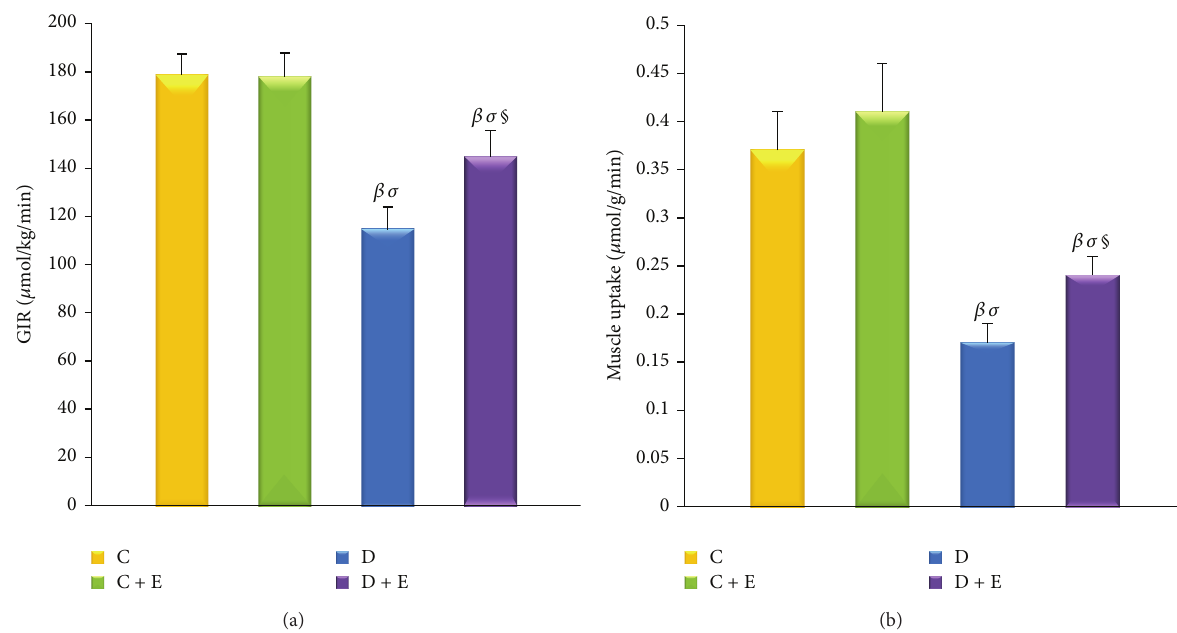
Figure 6: Exogenous glucose infusion rates (GIR) and 2-deoxyglucose uptake into muscle. The GIR required to maintain the glucose levels at the clamp point (6-7mmol/L) was higher ( 𝑃 < 0.01 ) in the D + E group rats than that in the D group rats, while it was still significantly lower ( 𝑃 < 0.01 ) than that in the C group rats. The GIR did not differ between the C group rats and in the C + E group rats (a). Exenatide treatment for 8 weeks markedly increased glucose uptake in diabetic rat gastrocnemius compared with the vehicle-treated diabetic rats ( 𝑃 < 0.01 ). Increased glucose uptake was also found in the C + E group rats compared with the C group rats, but this did not reach statistical significance (b). C: nondiabetic control; C + E: nondiabetic + exenatide; D: diabetic; D + E: diabetic + exenatide. Data are presented as mean ± SD. ∗ 𝑃 < 0.01 , # 𝑃 < 0.05 compared with basal. 𝛽 𝑃 < 0.01 , 𝛼 𝑃 < 0.05 compared with C group. 𝜎 𝑃 < 0.01 , 𝛾 𝑃 < 0.05 compared with C + E group. § 𝑃 < 0.01 , 𝜑 𝑃 < 0.05 compared with D